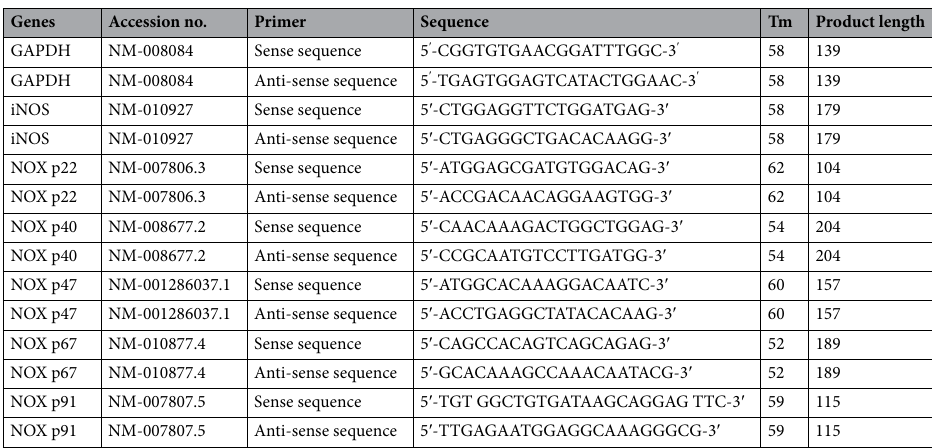
Table 7. Designed primers used in qPCR, melting temperature (Tm) of the primers, and the size of their specific